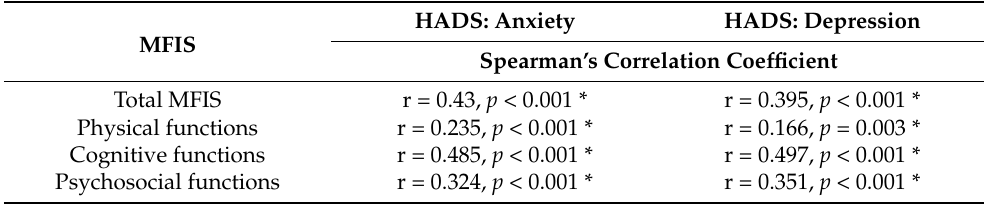
Table 5. Correlations between the MFIS and HADS scores.